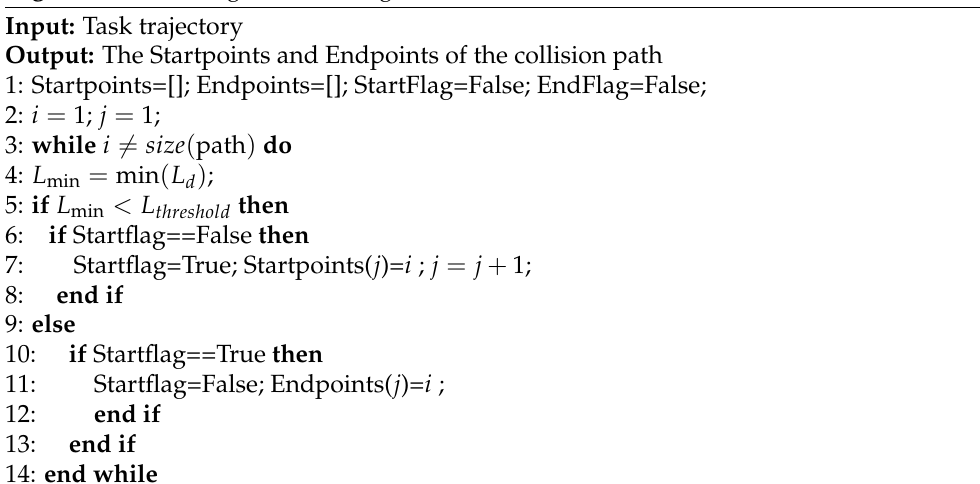
Algorithm 1 Path segmentation